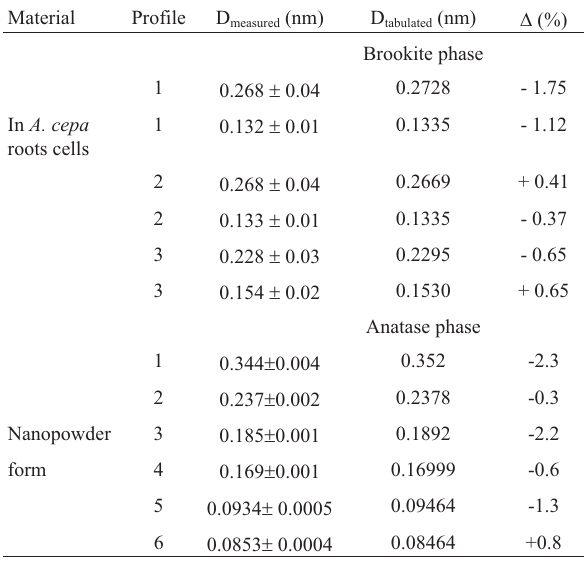
Table4 -Analysisbyselectedareaelectrondiffraction(SAED)insuspen- sion and inside cells of A . cepa roots exposed to 1000 mg/L TiO 2 NP. Material